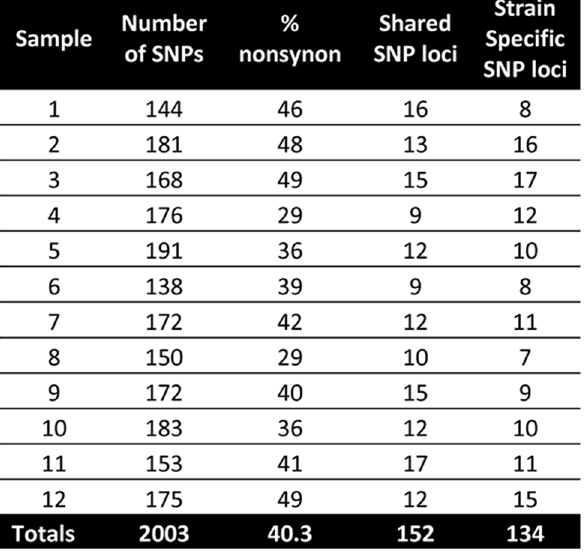
Fig 2. Annotation of the number of single nucleotide polymorphisms (SNP), percentage of SNPs which were nonsyonymous, number of shared SNP loci among study isolates (1 through 12) and number of strain specific SNPs among study